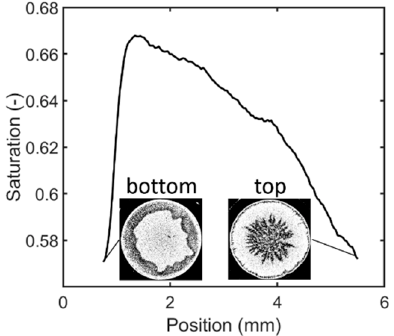
Figure 6. Variation of the saturation with height of the sample after 11.5 h of drying. The image at the bottom side refers to position 0.72 mm, and the image at the top side refers to position 5.47 mm (measured from the sample footprint). In total, 138 images were considered (with distance 0.0344 mm between them).